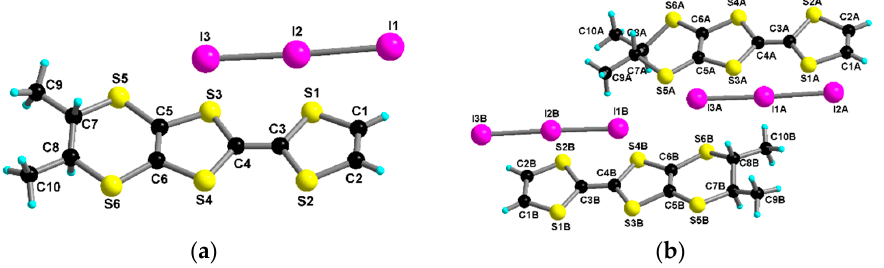
Figure 8. ( a ) Molecular structure of [( rac )- 2 ]I 3 with together with the atom numbering scheme; ( b ) Molecular structure of [( R,R )- 2 ]I 3 together with the atom numbering scheme.